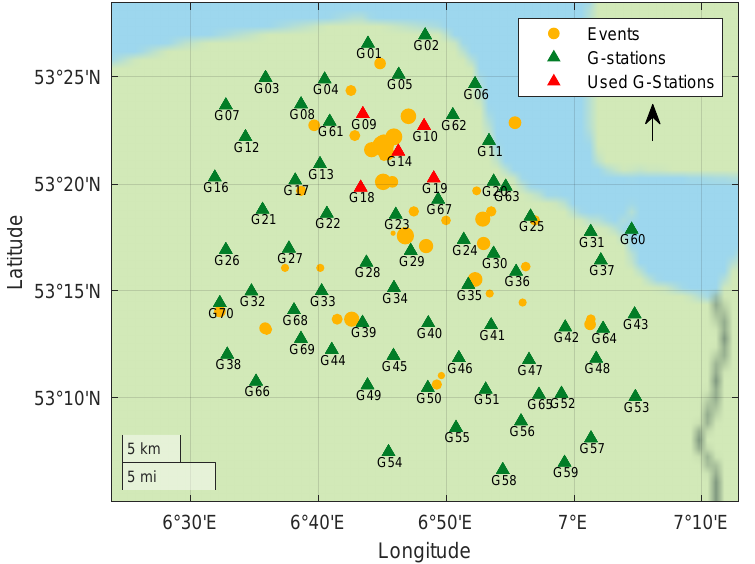
Figure 6. Map of the G-network stations (green and red) and the 23 cataloged events (orange) that occurred during December 2017 and January 2018. The selected five stations (shown in red) are used to test the trained CNN model on a two-month continuous